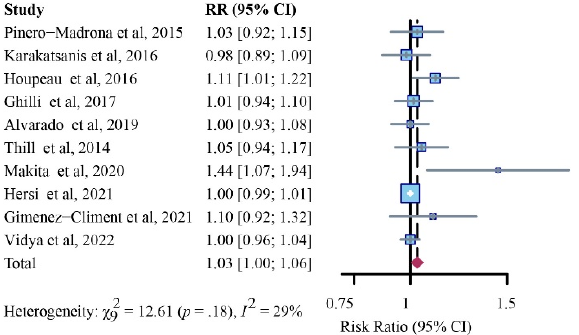
Figure 7. Relative risk (RR) analysis of positive SLN identification rates for SPIO versus standard